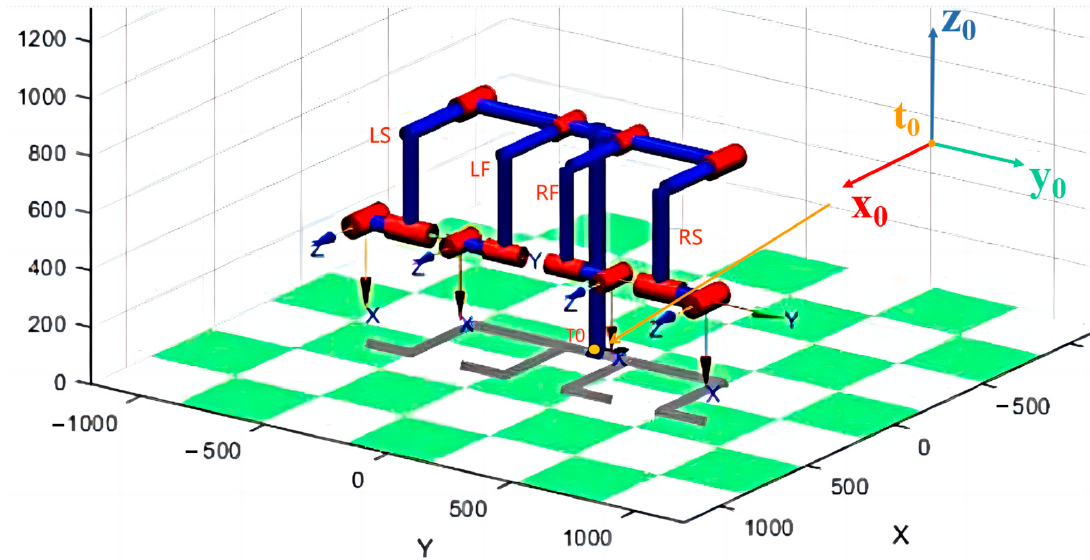
Figure 3. D-H model of four-manipulator system and base coordinate system T 0 .